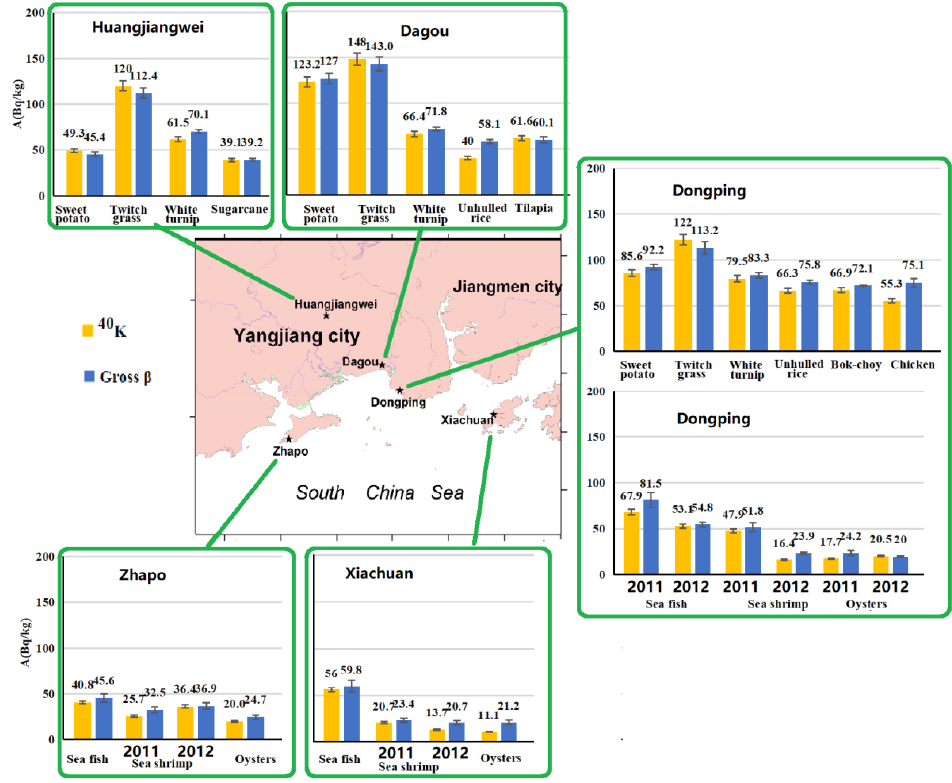
Figure 3. 40 K and gross beta in the organisms collected from Yangjiang and the adjacent areas.